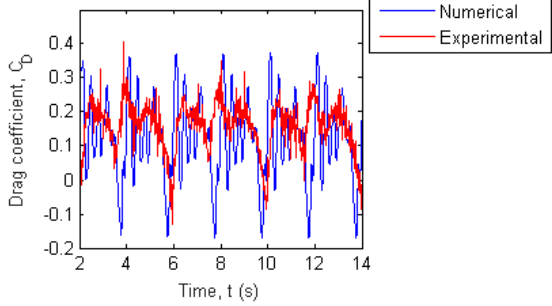
Fig. 9. Numerical and experimental results comparison of the time evolution of drag forces.